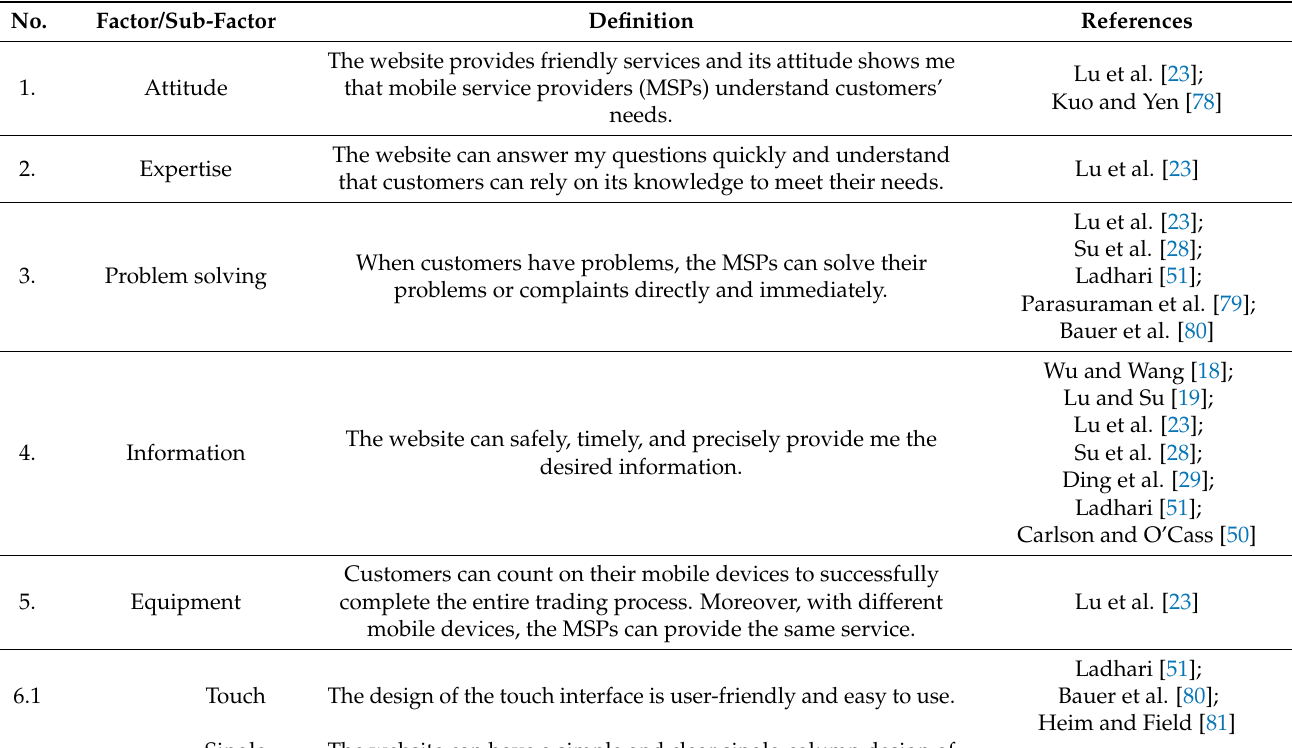
Table 4. Service quality factors of programmatic